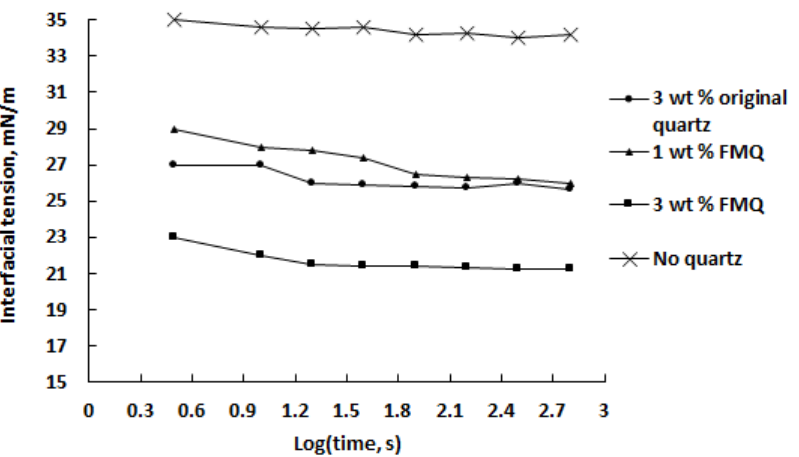
Figure 11. Interfacial tension of the saline water – crude oil interface as a function of contact time with quartz at different demulsifier dosages.